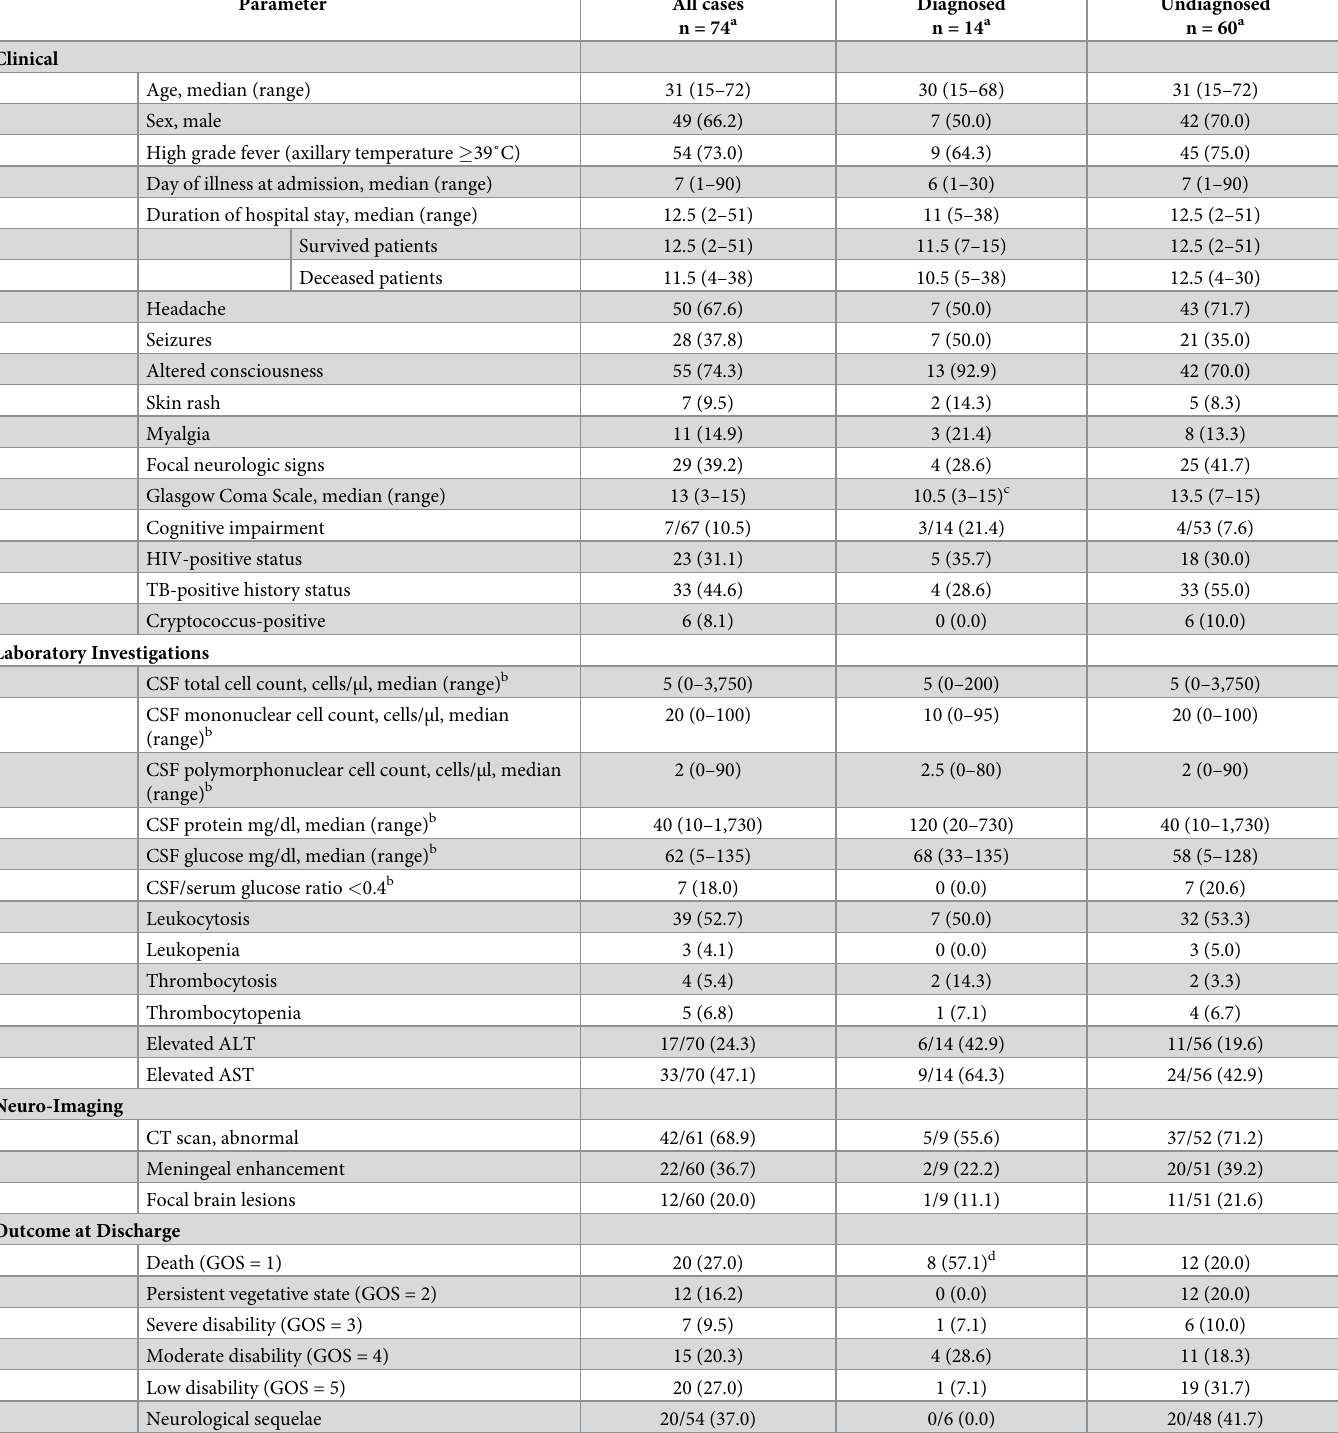
Table 1. Characteristics of adult patients with suspected CNS infection enrolled in this